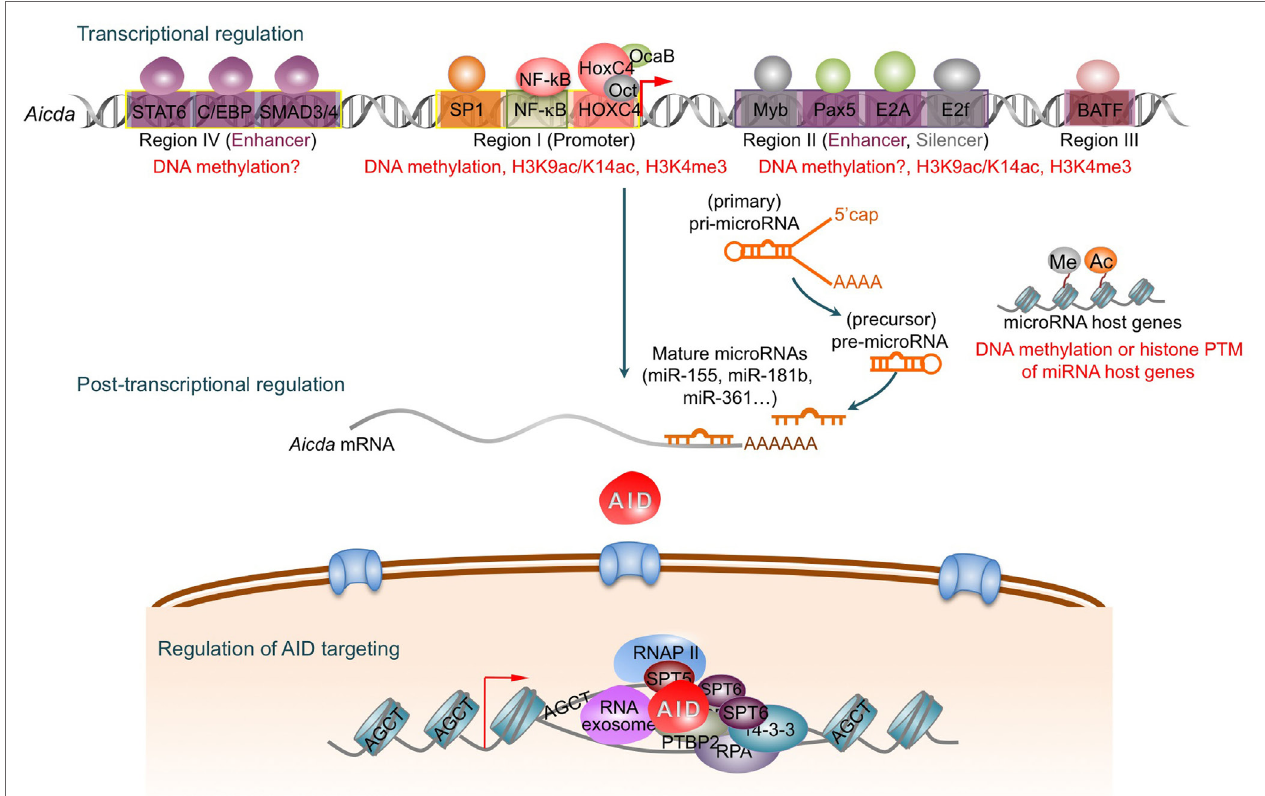
FiGURe 1 | AiD is tightly regulated at the transcriptional, post-transcriptional, and post-translational levels . Four distinct DNA regions (regions I–IV) of the AID gene ( Aicda ) locus possess binding sites for multiple transcription factors to regulate Aicda expression. Region I functions as promoters containing the binding sites for HoxC4/Oct and NF- κ B/Sp1/Sp3, which can be induced by activating the Aicda promoter. In resting naive and memory B cells, and non-B cells, silencer elements in region II bind the repressor proteins E2f and c-Myb to counter the activity of the transcriptional activators. Stimulation of B cells with the primary inducing stimuli and cytokines that promote CSR induce activation signals through region IV enhancer in collaboration with the intronic enhancer in region II can overcome the effect of the region II silencer. After transcription, the Aicda mRNA can be negatively regulated by miR-155, miR-181b, and miR-361, which specifically bind to the conserved target sites on the 3 ′ UTR of Aicda mRNA. Nuclear AID is either degraded or exported back to the cytoplasm. Only a small proportion of AID molecules are targeted onto DNA at Ig or non- Ig loci by its co-factors. AID preferentially deaminates single-strand DNA, which emerges from transcription by RNA Pol II and depends on histone modifications in the transcribed locus. AID can be recruited to the open DNA before or during transcription. In CSR, AID recruitment to S regions occurs with interaction of RNA Pol II and AID-interacting factors, such as Spt5, Spt6, PTBP2, RNA exosome, lncRNAs, and 14-3-3 adaptor proteins, which would form a macromolecular complex. AID is enriched and stabilized on the targeted DNA by 14-3-3 adaptor proteins, which access the same S regions as the transcription machinery owing to their open chromatin state. These 14-3-3 adaptors are recruited and/or stabilized through interactions with 5 ′ -AGCT-3 ′ repeats and possibly by H3K9acS10ph. The RNA exosome also interacts with AID and allows AID to deaminate both the transcribed and the non-transcribed DNA strand in the S regions undergoing transcription. AID deaminate dCs into dUs to yield dU:dG mismatches. Resolution of these lesions can lead to different physiological or pathological